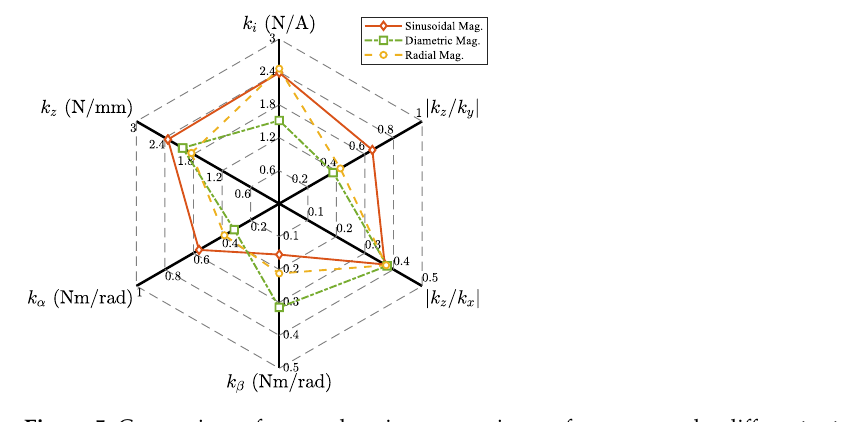
Figure 5. Comparison of comprehensive suspension performance under different rotor magnetization